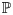
Sketch of the model.Currently quiescent (active) citizens are represented by blue (red) cells, while LEOs are represented by black cells. Yellow cells show the Moore neighborhood for an agent. Green cells show a vision of radius 4 for the citizen (blue cell). During a move, an agent inspects every cell within its vision radius (green). If there is a preferential gathering site in the vision radius, then the active agent moves in his/her Moore neighborhood in the direction of the closest site with probability P (in a simulation, P is fixed at either 0%, 25%, 50%, 75%, or 100%). Otherwise, an agent picks a random cell in his/her (Moore) neighborhood and, if the selected cell is unoccupied, he/she moves there; otherwise the agent stays put. Pink cells show a vision of radius 4 for the LEO (black cell). The LEO can intimidate the nearest active citizen in its field of vision (in this model, with probability 1). If there is no active citizen, then the LEO moves to a random cell in its Moore neighborhood in the same manner that a citizen does. The citizens calculate their state depending on conditions on the lattice within their field of vision.